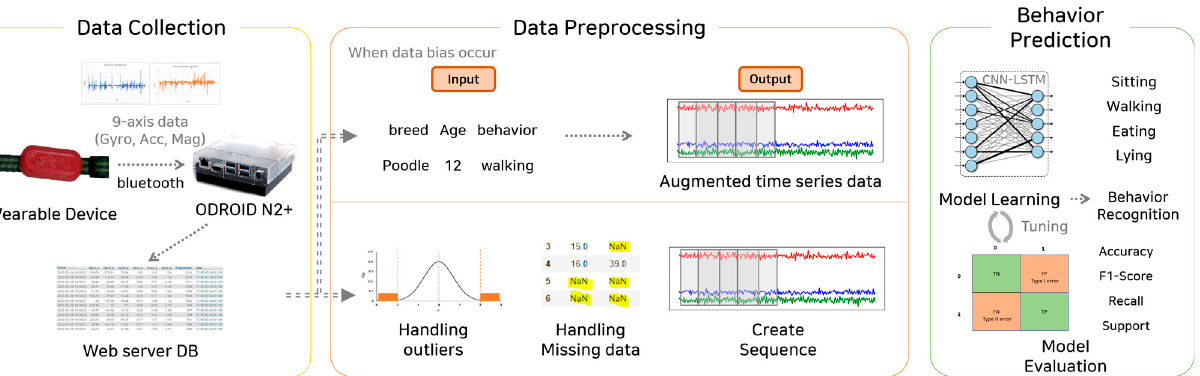
Table 1. Comparison of research on behavioral recognition based on sensor data.